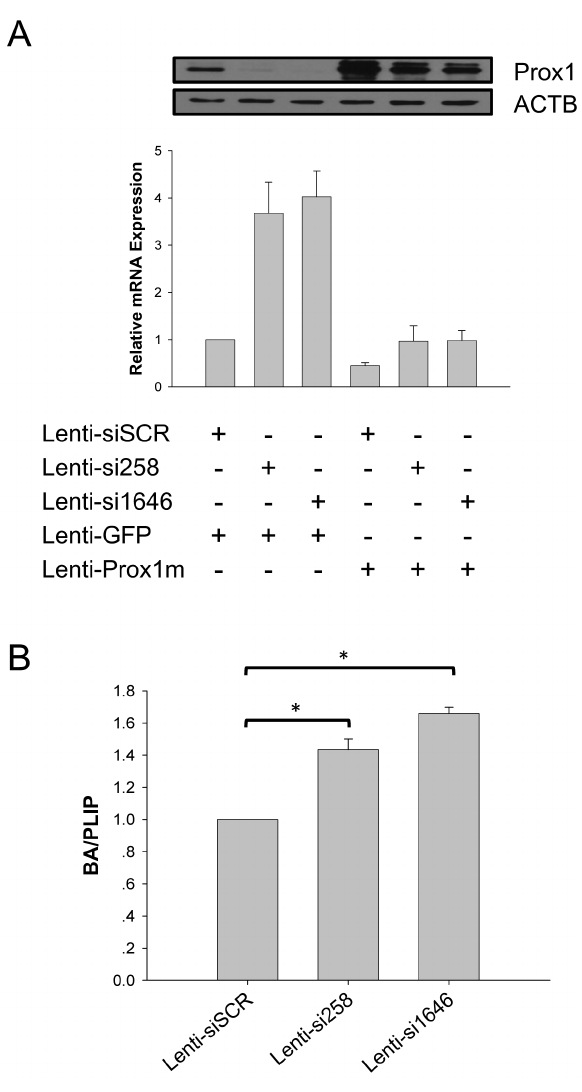
Figure 1. Prox1 represses CYP7A1 transcription and bile acid synthesis in HepG2 cells. (A) Prox1 represses transcription of